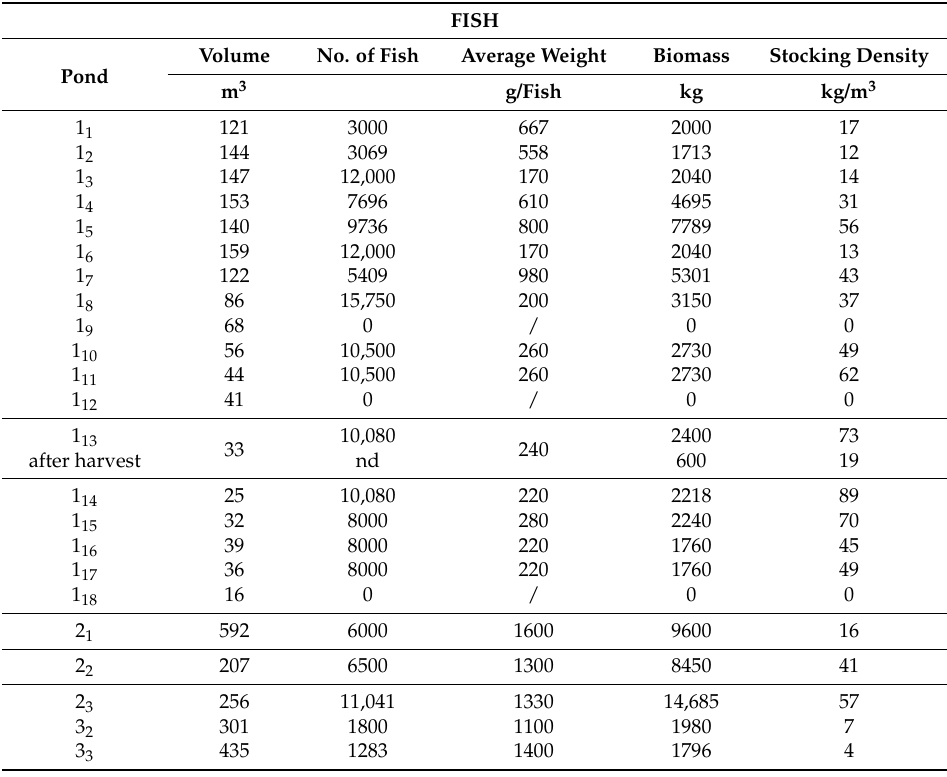
Table 1. Outcome of fish data for the whole fish farm at the moment of the experiment. The figures 0, 1, 2 and 3 for ponds number are theoretical numbers of water uses (see Figure 7).